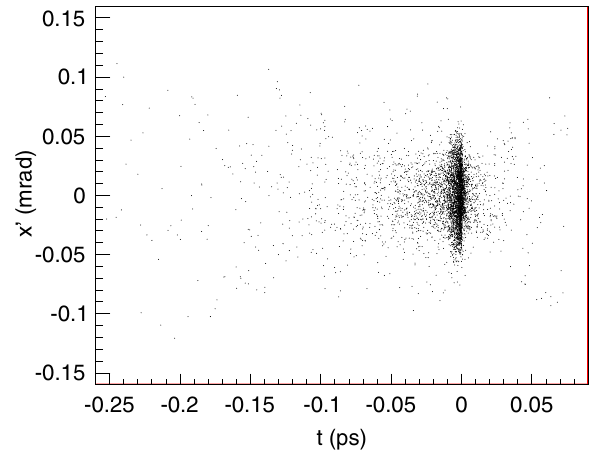
FIG. 8. Transverse phase space consisting of electron position ( x ) and angle ( x 0 ) of a beam at the sample